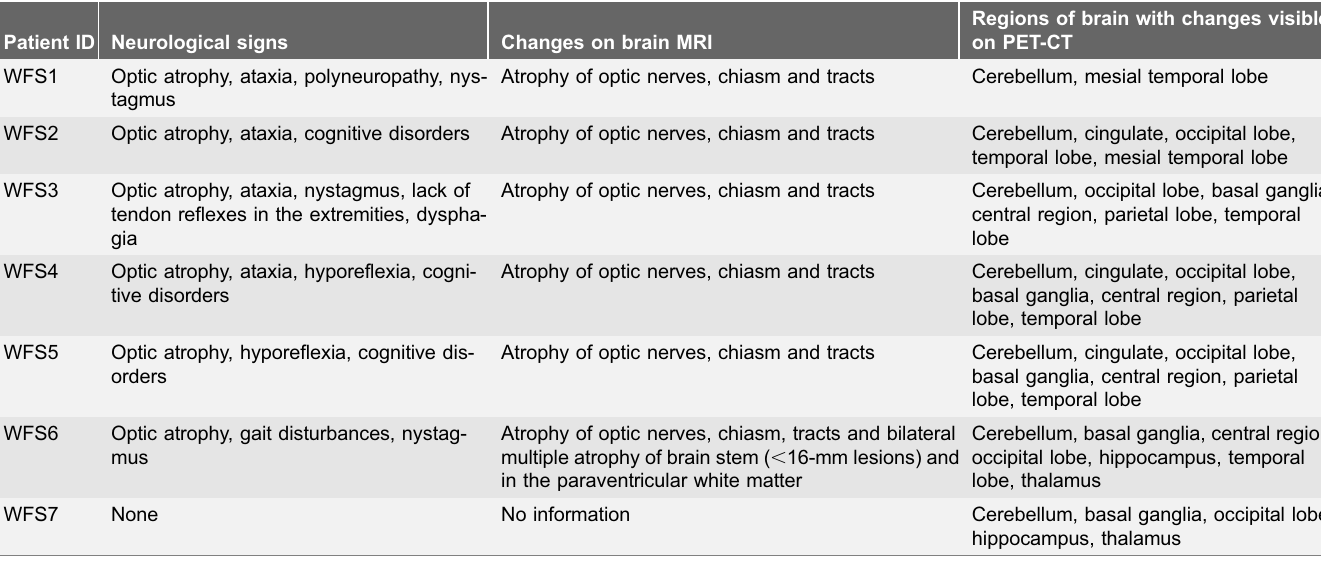
Table 2. Neurological characteristics and detected changes in brain MRI and PET-CT studies in patients with Wolfram syndrome.